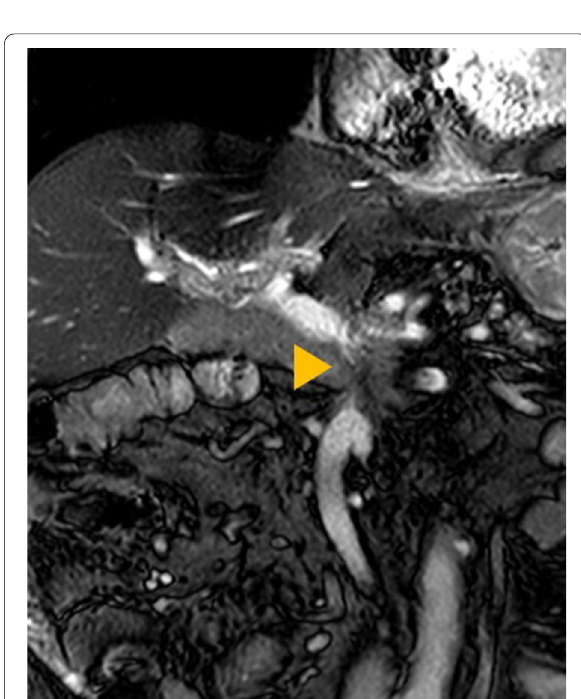
Fig. 3 Preoperative findings of contrast-enhanced Magnetic Resonance Imaging (coronal image). The superior mesenteric vein was obstructed 2 cm near the splenic vein confluence (arrowhead), and the splenic vein was